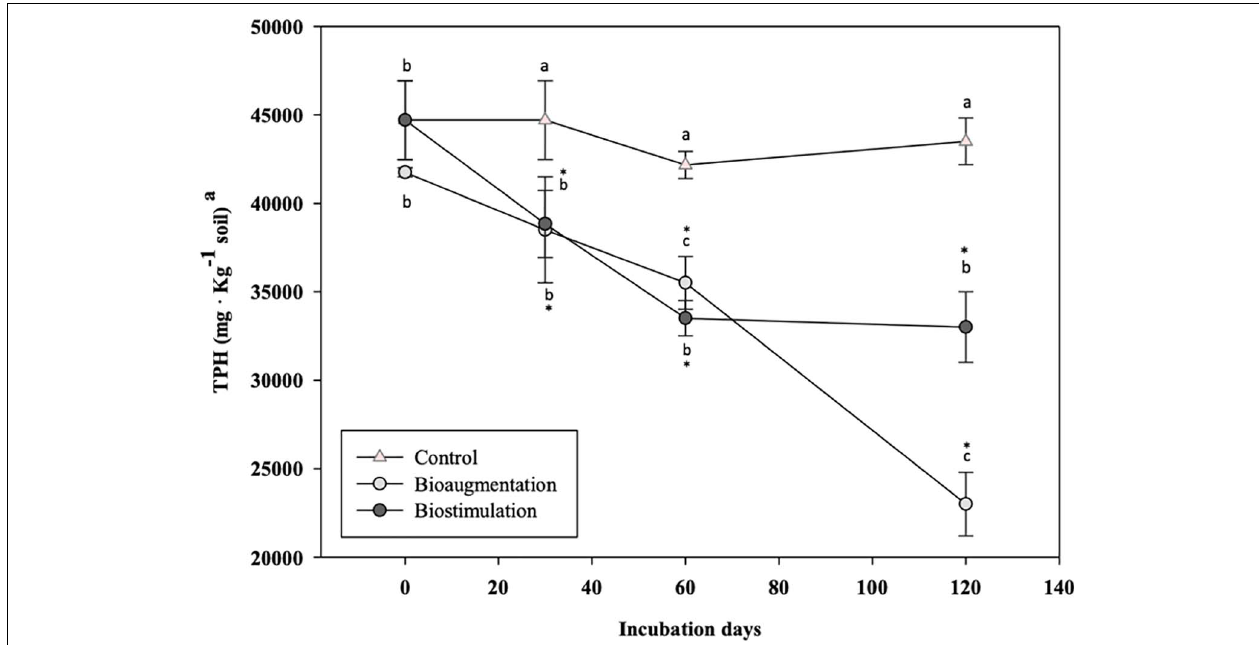
FIGURE 1 | TPH concentration evolution in microcosm assays along 120 days of incubation. a Data are the means of three independent experiments. a , b , c Same lower-case letters indicate lack of statistically significant difference ( P < 0.05) between each biostimulation or bioaugmentation treatment. *Asterisk represents the occurrence of significant differences between B and BS treatments with control C ( P < 0.05). Values are expressed in terms of dry weight.